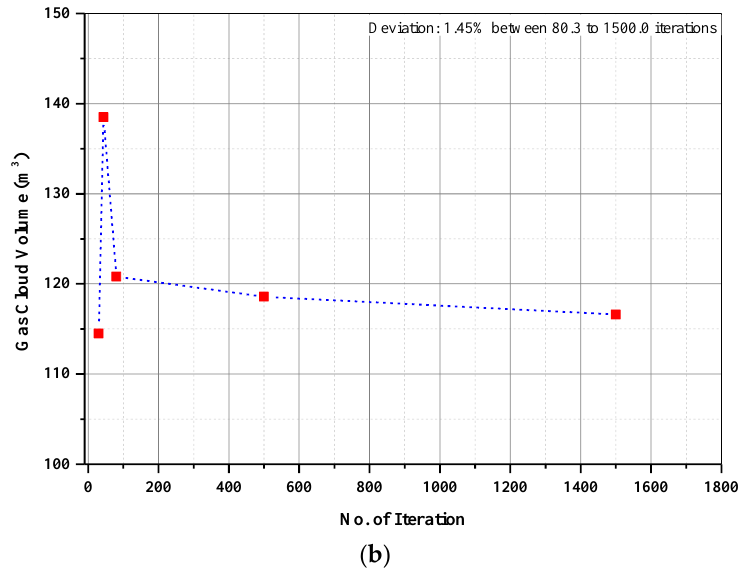
Figure 12. Plots of gas cloud volume versus number of grids ( a ) and iteration numbers ( b ).